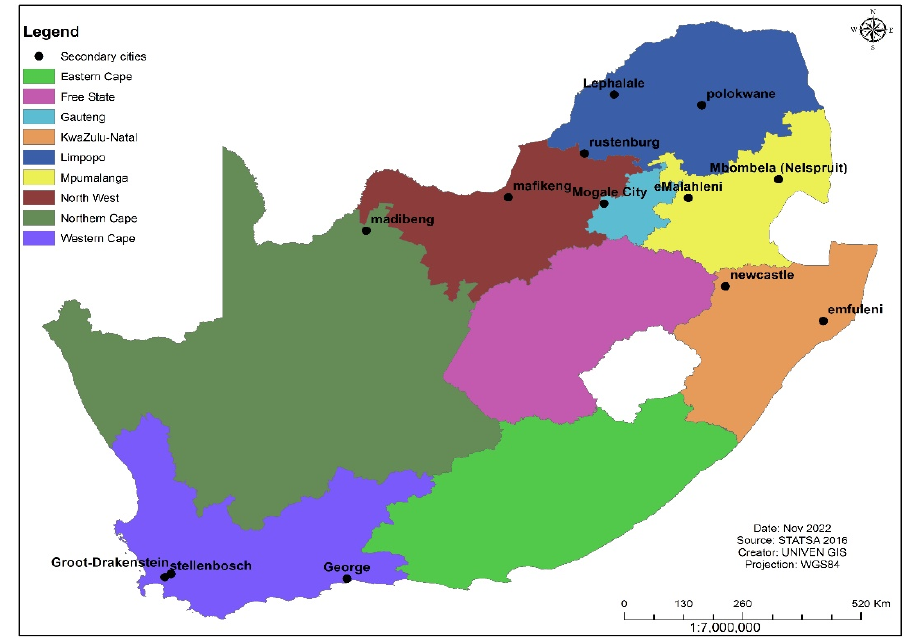
Figure 4. Map of secondary cities 3 in South Africa.